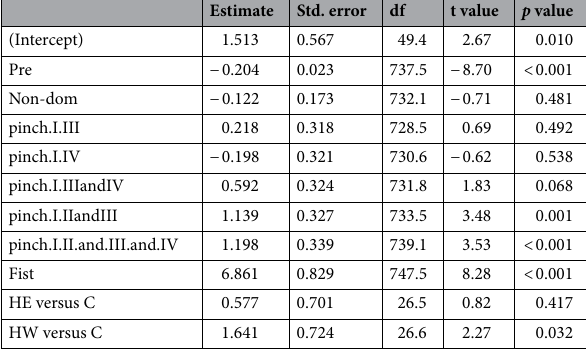
Table 1. Mixed effects model with all 7 measurements sites.